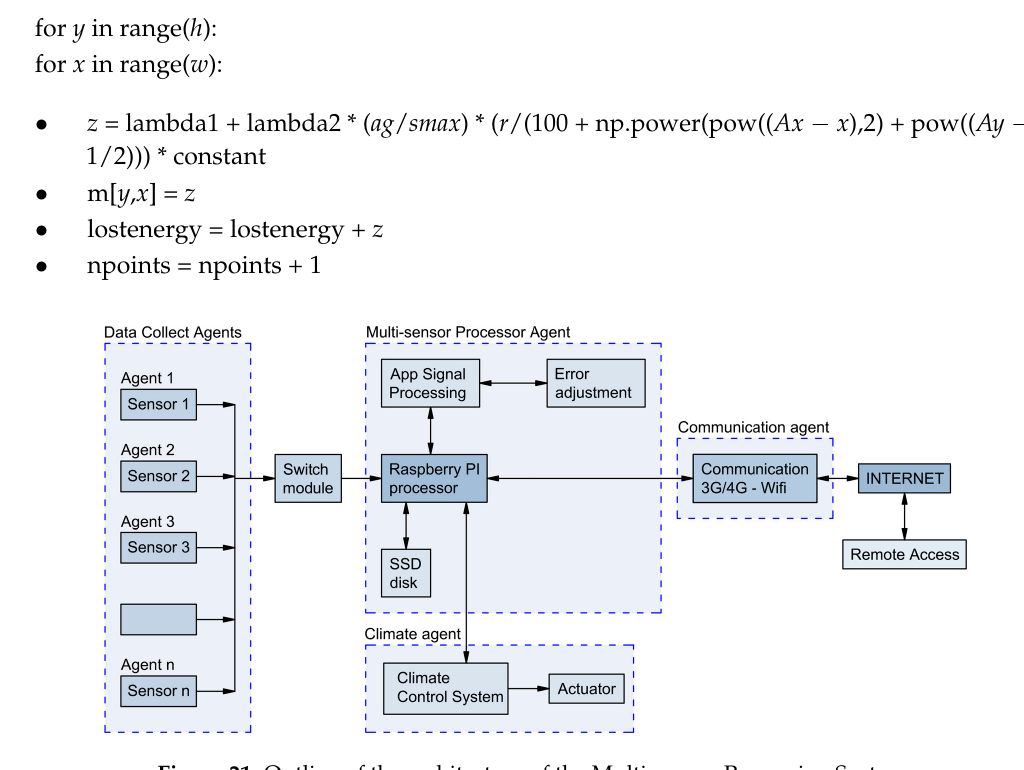
Figure 23. Image of the assembly of the system, with the Data Logger, the Raspberry Pi Processor and the GPRS Communication. 8. Discussion: Comparative Analysis of Results Conclusions can be drawn by analysing the enclosure’s behaviour in static regime or according to Fourier’s law, compared to the actual behaviour obtained by monitoring and subsequent correction of results [44]. The thermal resistance obtained by monitoring was lower than the thermal resistance obtained via theoretical calculations or Fourier’s mathematical model. The differences were considerable. Table 9 shows the values relating to the thermal gap between both sides of the polyurethane foam insulation, and the temperature gaps between indoor and outdoor air temperature, on selected days, as well as the percentages of the comparative values. Average values of the values collected every half hour were calculated in order to mitigate the effect of thermal inertia in this comparative quantification. As shown, the thermal gap in the insulation, according to monitoring results, varied between 30.2% and 43.06% of the thermal gap T i − T o . However, in the